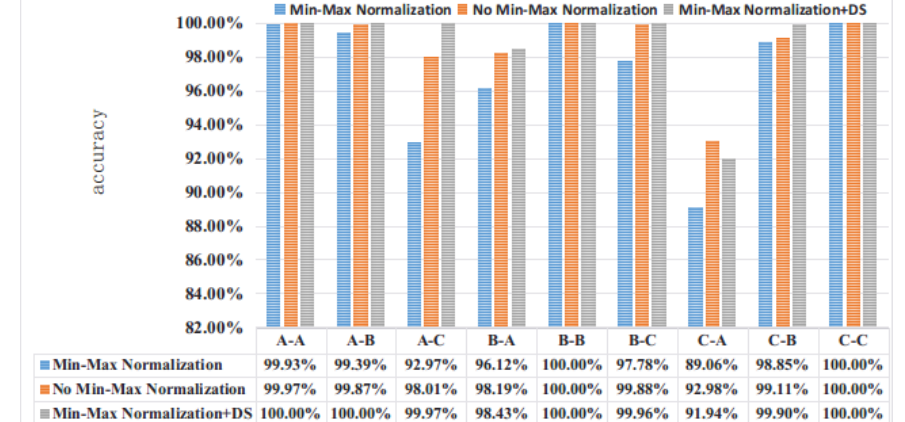
Figure 7. Comparison of Min-Max Normalization over 20 experiments.